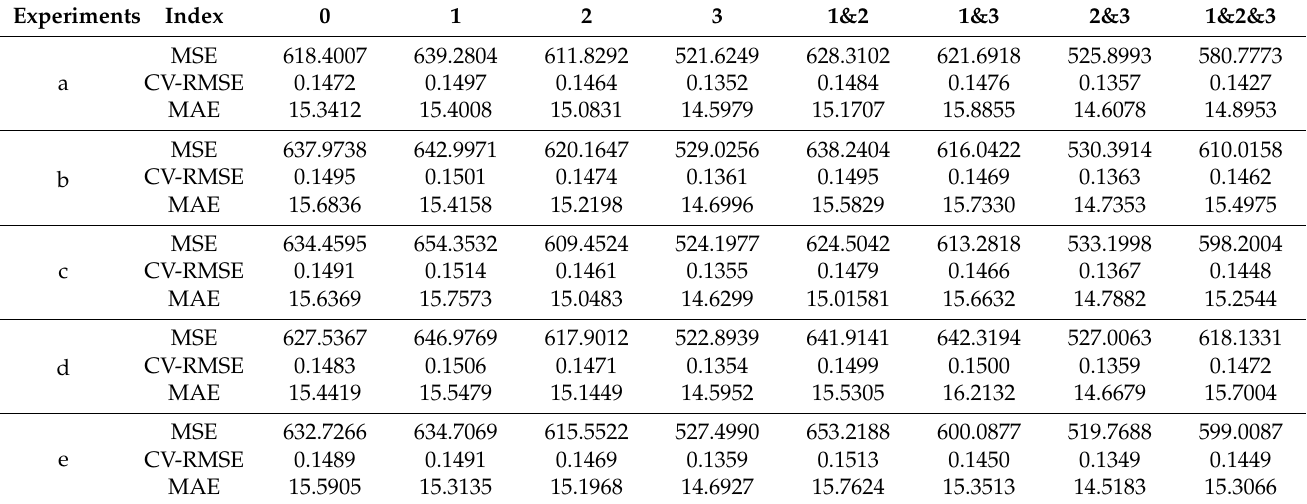
Table 3. Calculation results of indicators after adding different parameters to the